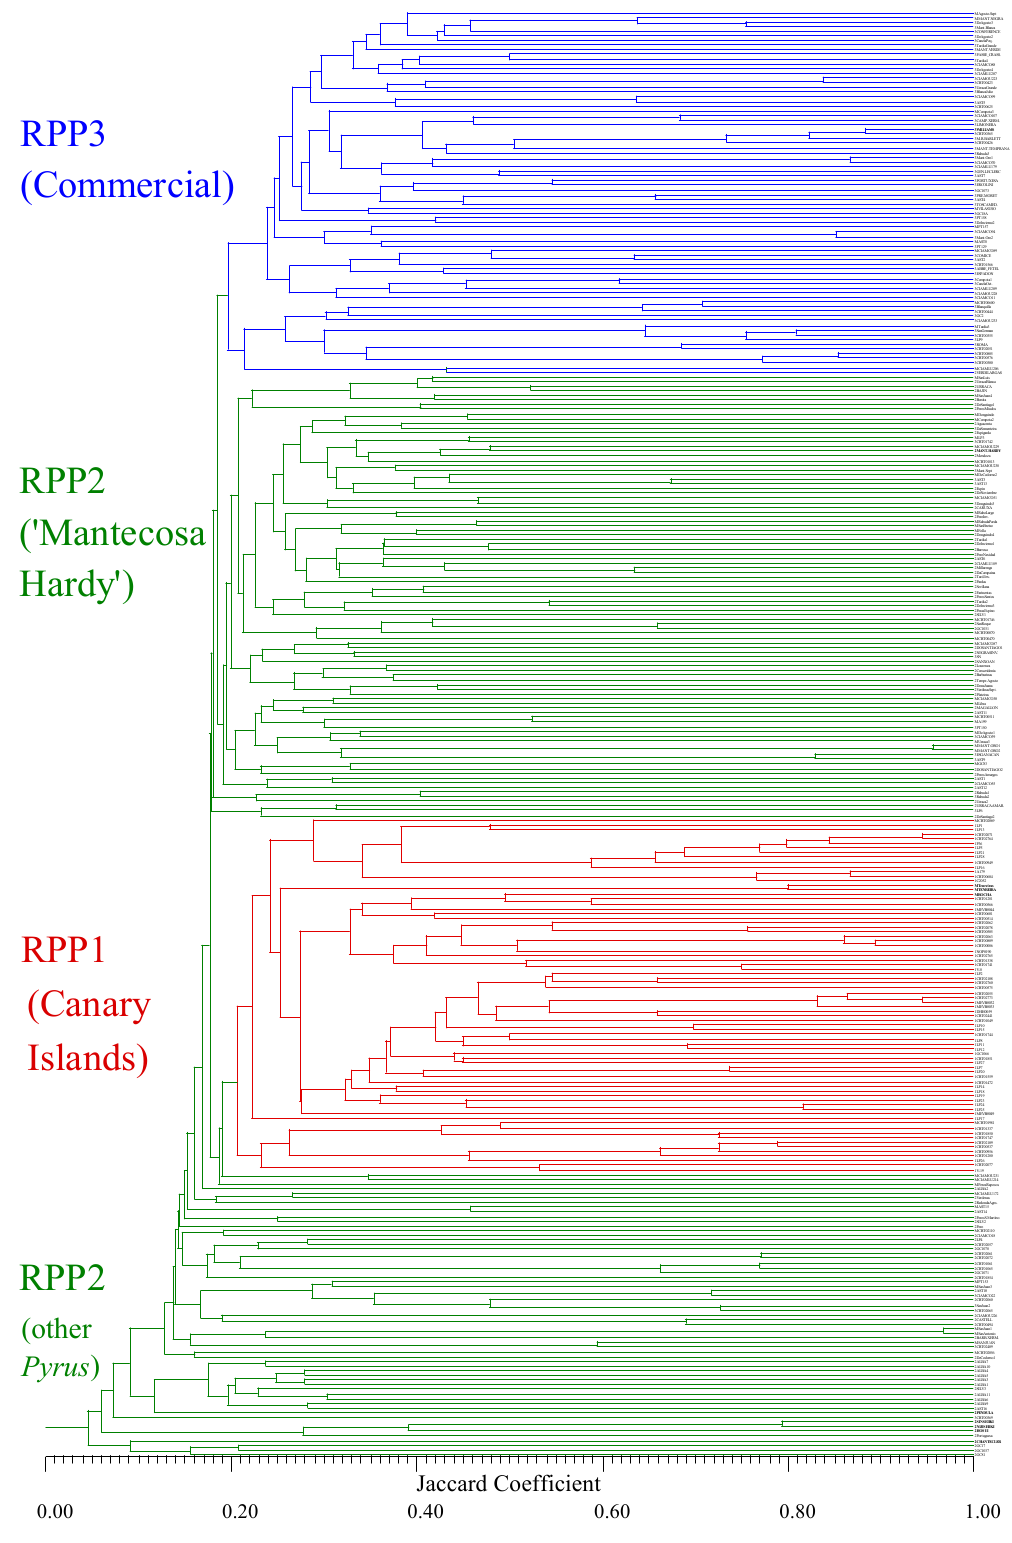
Figure 3. Dendogram for the 310 unique pear genotypes based on Jaccard’s coefficient with an indication of the reconstructed panmictic populations for K = 3 and 18 SSRs. The RPP number assigned by the STRUCTURE software is indicated before the genotype code/name.